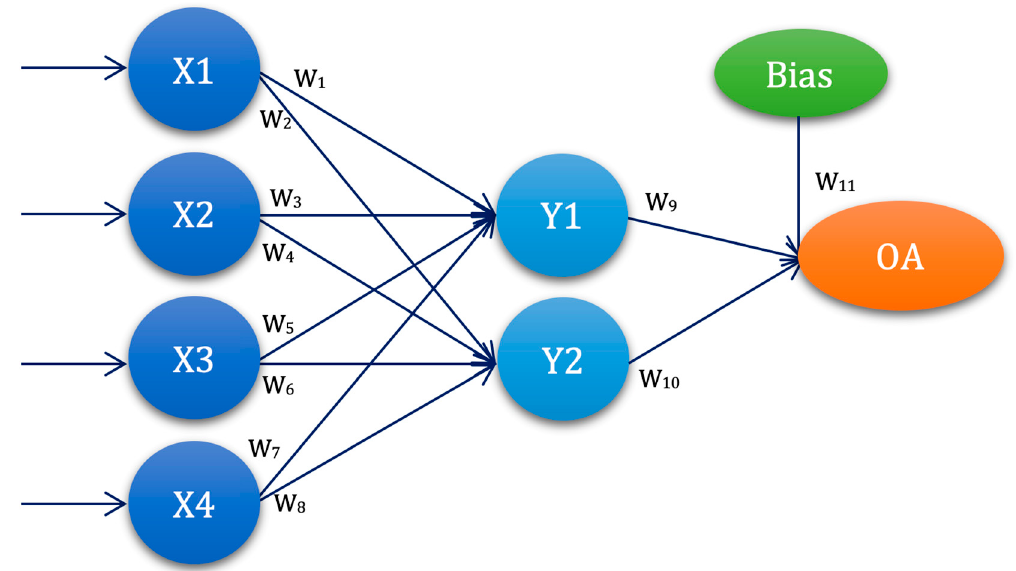
Figure 2. ANN-L12 architecture—graphical representation. Table 1. ANN-L27 orthogonal vector